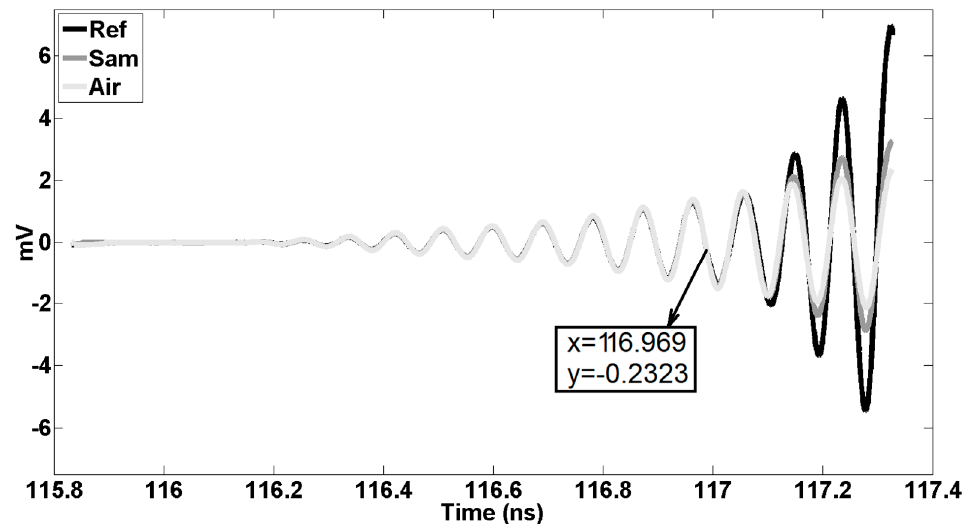
Figure 7. The first estimation of the nose, the growing deviation between the two curves.